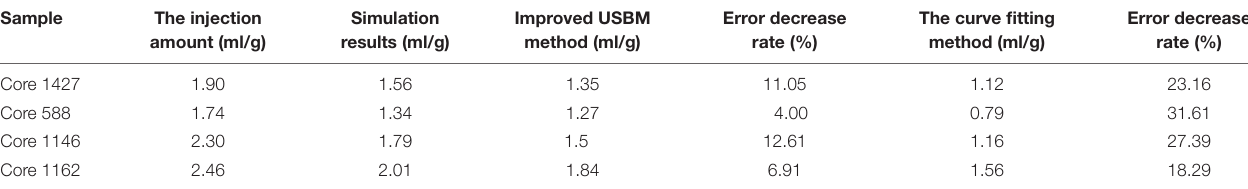
TABLE 5 | Comparison the volume of shale gas loss obtained by three methods. Sample The injection Simulation amount (ml/g) results (ml/g)